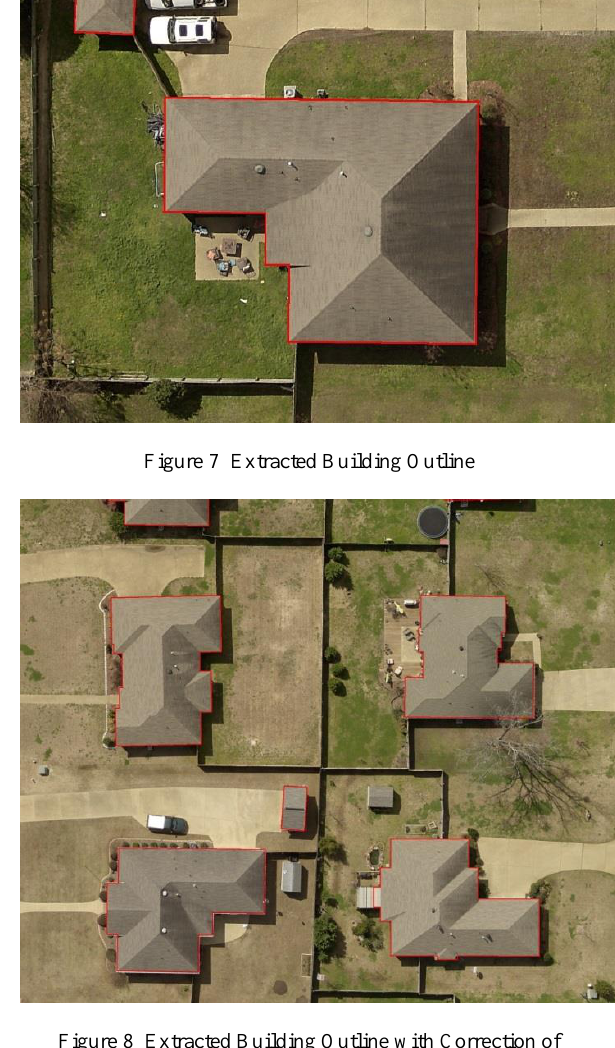
Figure 8 Extracted Building Outline with Correction